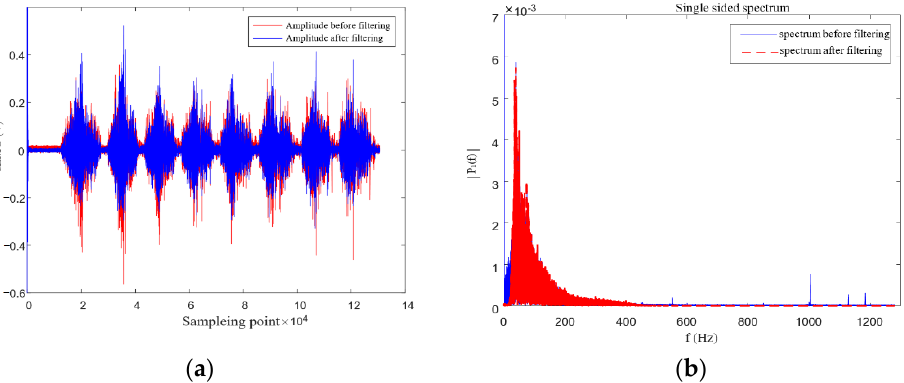
Figure 1. sEMG characteristics with a filter: ( a ) amplitude comparison and ( b ) spectrum compari- son.